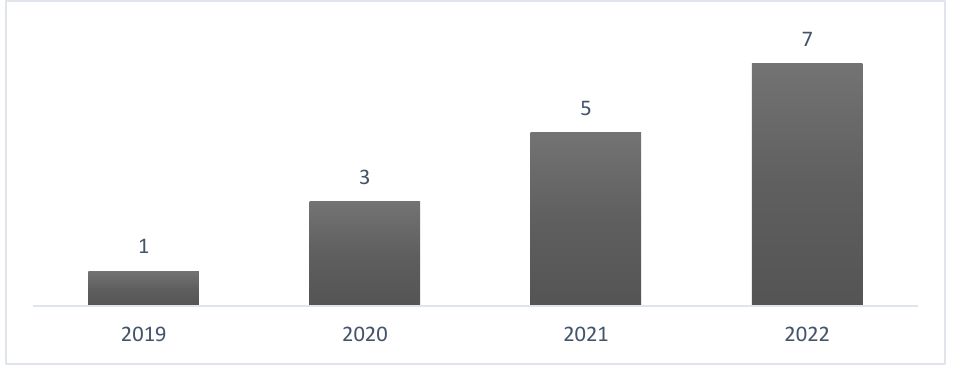
Figure 2. Publication year.